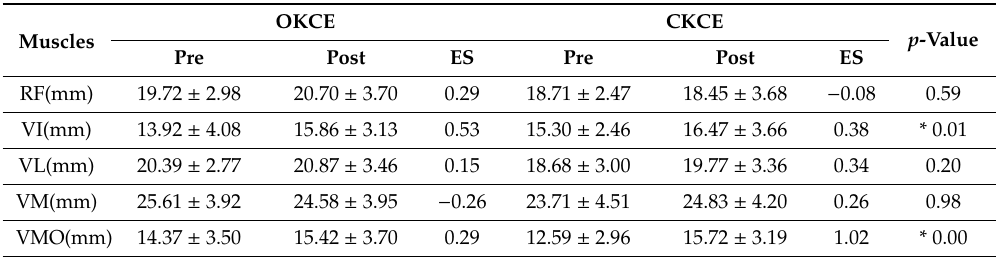
15.42 ± 3.70 0.29 12.59 ± 2.96 * 0.00